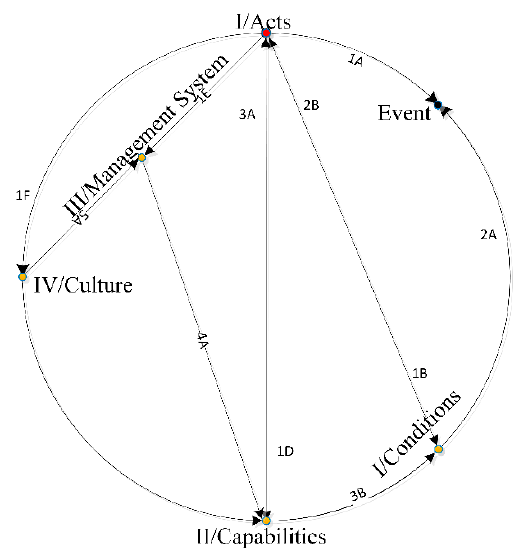
Figure 4. Process of reasons affecting accidents [35]. Reproduced with permission from Gui and Ren, [24Model (Version 5)]; published by [Fifth edition 24Model, http://blog.sciencenet.cn/blog-603730-1083115.html.], [2017].